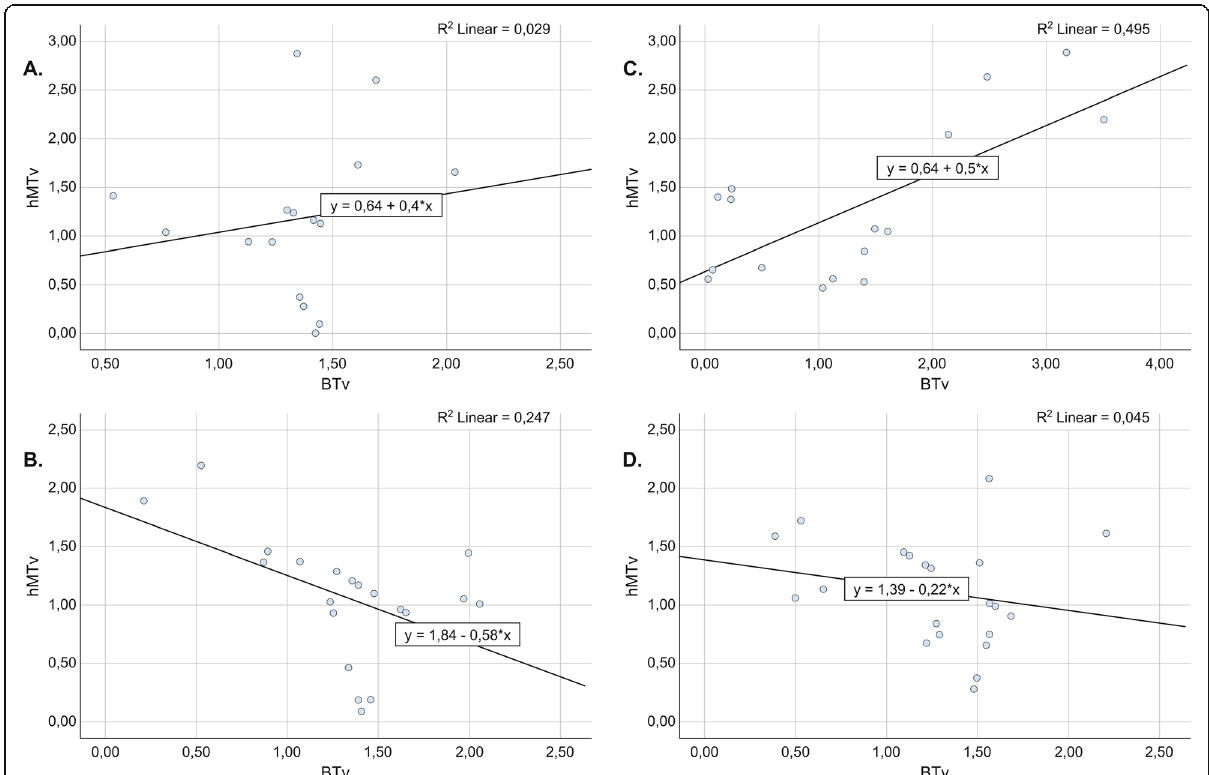
Fig. 4 Regression plots depicting the dependency between mucosal thickness (hMT) and bone thickness (hBT) values at v0-v3. a E B ( R 2 = 0.029, B = 0.396, p = 0.532). b P ( R 2 = 0.247, B = − 0.426, p = 0.026). c EB + rhBMP-2 ( R 2 = 0.495, B = 0.50, p = 0.002). d P + rhBMP-2 ( R 2 = 0.045, B = − 0.217, p =